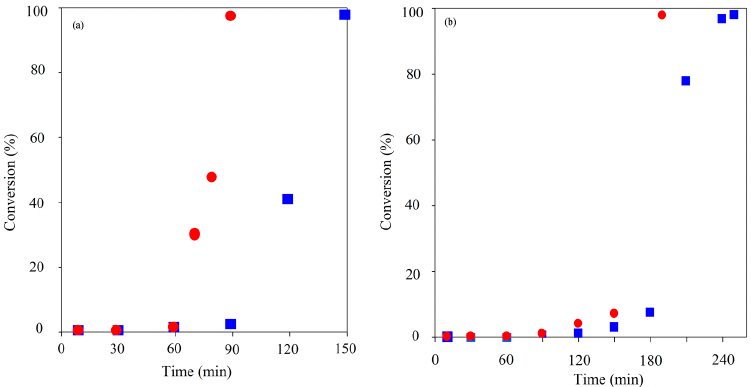
Figure 2. Comparison of TMP initiated ROP kinetics using CH ( ) & MWH ( ) at 150 °C and target DP 90 ( left ) and 21 ( right ).